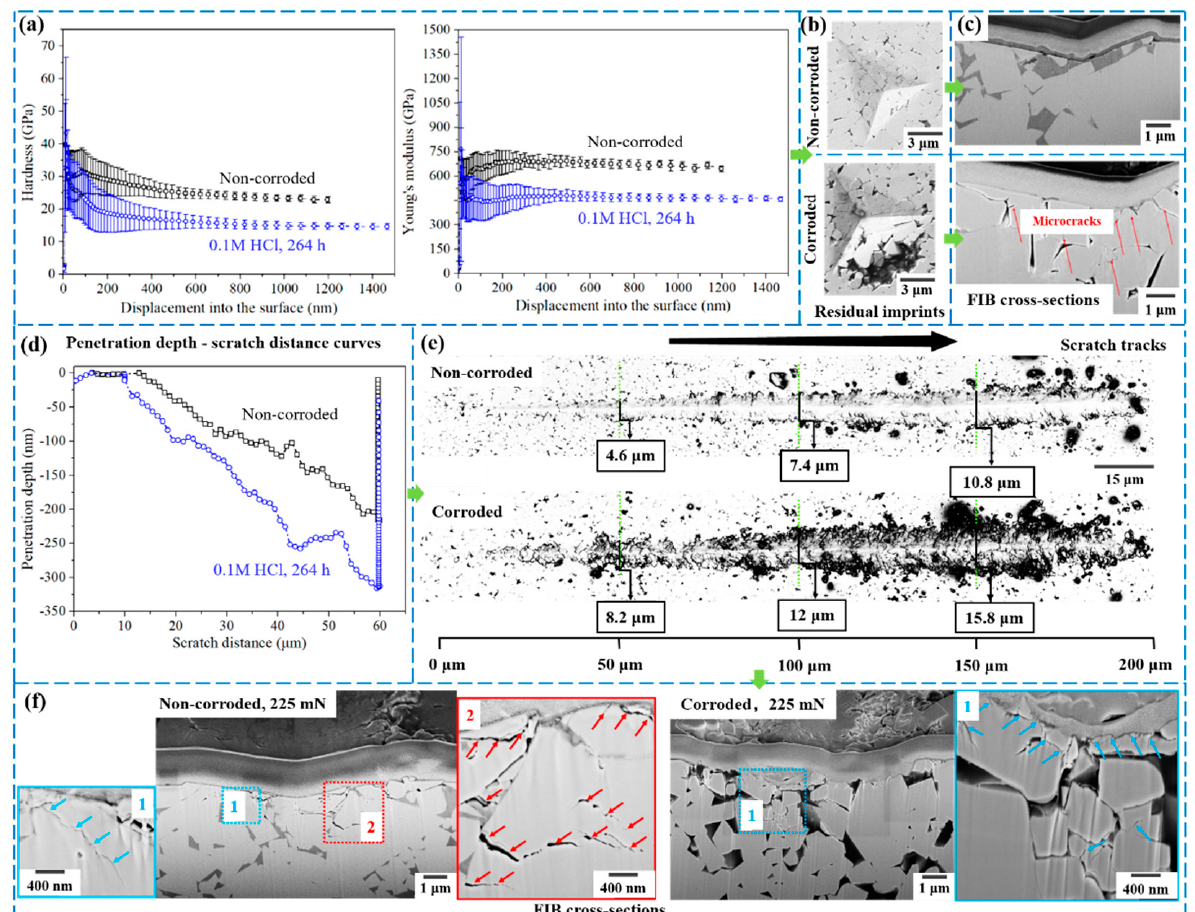
Figure 3. ( a ) Hardness and Young’s modulus values as a function of penetration depth, ( b ) nanoindentation residual imprints, ( c ) FIB cross-section of indented surface, ( d ) typical penetration depth—scratch distance (under increasing applied load condition) curves, ( e ) micrographs of two scratch tracks, and ( f ) FIB cross-sections of the scratch track corresponding to a load level of 225 mN for non-corroded and corroded 6CoM samples (adapted from Ref. [43]).